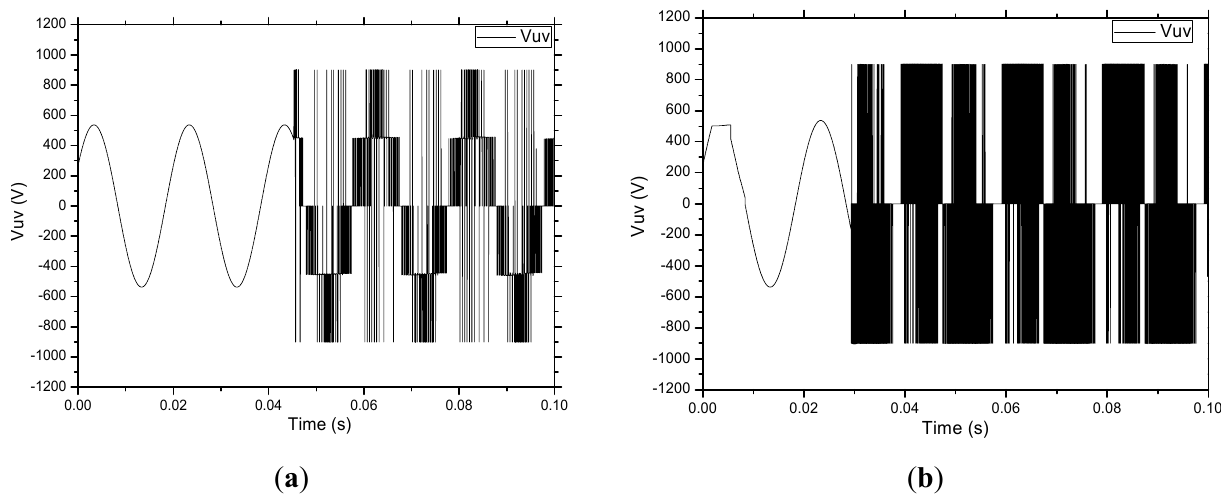
Figure 6. Line-to-line output voltage of the ( a ) three-level NPC-VSC converter and ( b ) two-level converter.